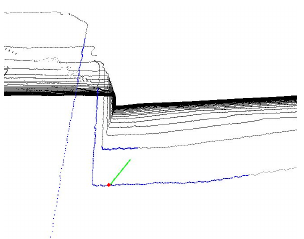
Figure 3: The estimated normal vector at the point around the boundary. The green line is the normal vector at the point col- ored red. Small blue dots are the neighborhood points used for estimating the normal vector.